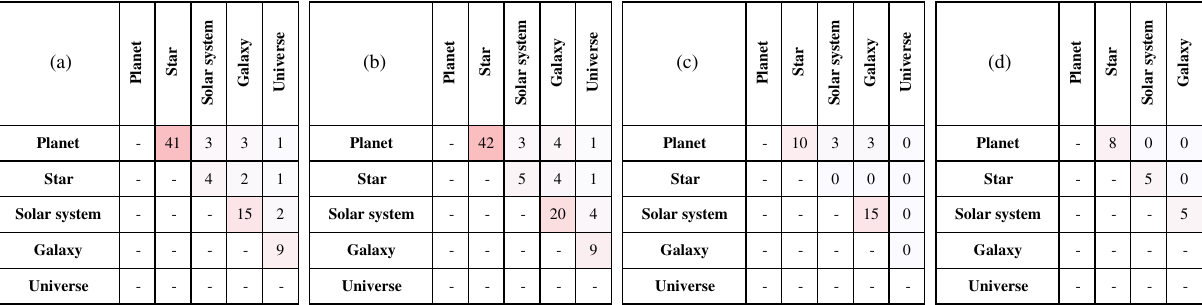
FIG. 3. Percentages of students who made specific pairwise errors on the size ranking task in Q5a; the sample groups (a) – (d) match those in Fig. 2. The elements of the matrix should be interpreted as follows: value in row i and column j = percentage of respondents who wrongly ranked item i as being larger than item j . The lower triangular part of the matrix is empty, since all pairwise relations here correspond to correct relative rankings. For example, matrix (a) tells us that 41% of the preinstruction middle school students wrongly ranked a planet as being larger than a star, regardless of the absolute ranks they assigned to either object or to any other objects, while 9% of them thought that a galaxy is larger than the universe. A color scale is superimposed on the elements of the matrix simply to highlight the most prevalent mistakes.